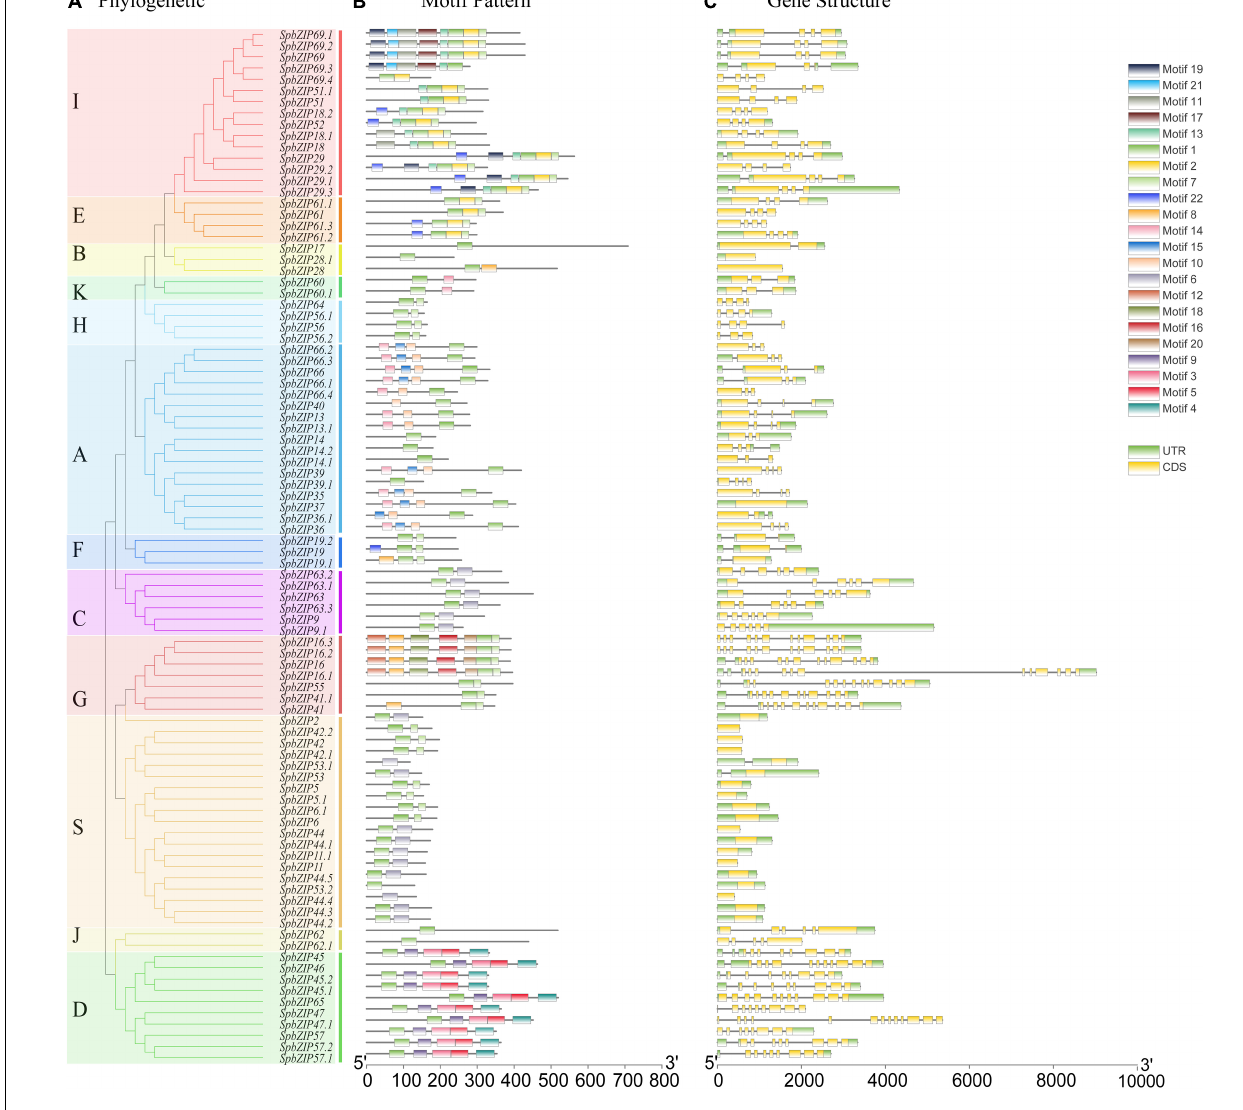
FIGURE 2 | Phylogenetic relationships, motif compositions, and gene structures of SpbZIP genes in S. plumbizincicola . (A) Phylogenetic analysis of S. plumbizincicola bZIP family members. (B) All conserved motifs in the SpbZIP proteins were identified using the MEME program. Different motifs are highlighted with different colored boxes (numbered 1–22). (C) Gene structures. Exons and 5’/3’ untranslated regions are indicated by green and yellow bars, respectively, whereas gray lines represent